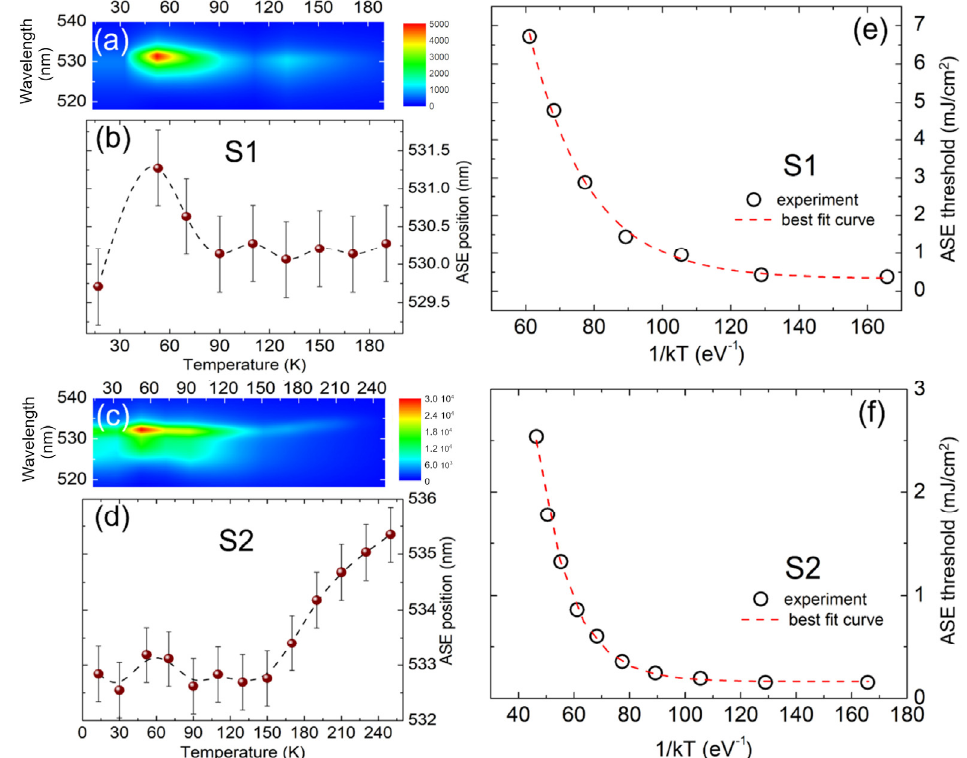
Figure 3. ( a , c ) 2D map of the PL spectra above the temperature for sample S1 ( a ) and S2 ( c ) recorded by exciting the films at an excitation density corresponding to the double of the threshold at each temperature. ( b , d ) Evolution of the ASE peak position (symbols) as a function of the temperature. Error bars are defined by the spectral resolution of the spectrometer used in the experiments (0.5 nm). The dotted lines are a guide for the eyes. ( e , f ) Arrhenius plots of the extracted ASE thresholds in sample S1 ( e ) and S2 ( f ) (symbols) and corresponding best fit curves (dotted lines) to Equation (1).